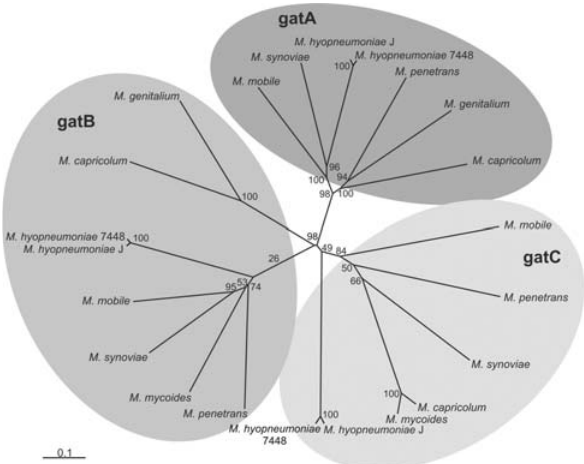
Figure 3 - Phylogenetic tree illustrating the relationships of gatA, B and C and related sequences. Phylogenetic analysis was based on the complete amino acid sequences of gat proteins. The tree was calculated by the neighbor-joining method implement in the program Clustal X, and drawn by using the TreeView program. The amino acid sequences are available at Mycoplasma databases. Gat protein sequences obtained from Mycoplasma databases were: M. capricolum (GenBank: YP_424670; YP_424122; YP_424671); M. genitalium (GenBank: AAC71317; AAC72482); M. hyopneumoniae J (GenBank: AAZ44118; AAZ44119; AAZ44117); M. hyopneumoniae 7448 (GenBank: AAZ53405; AAZ53406; AAZ53404); M. mobile (GenBank: AAT27863; AAT27862; AAT27864); M. mycoides (GenBank: CAE77379; CAE77381);